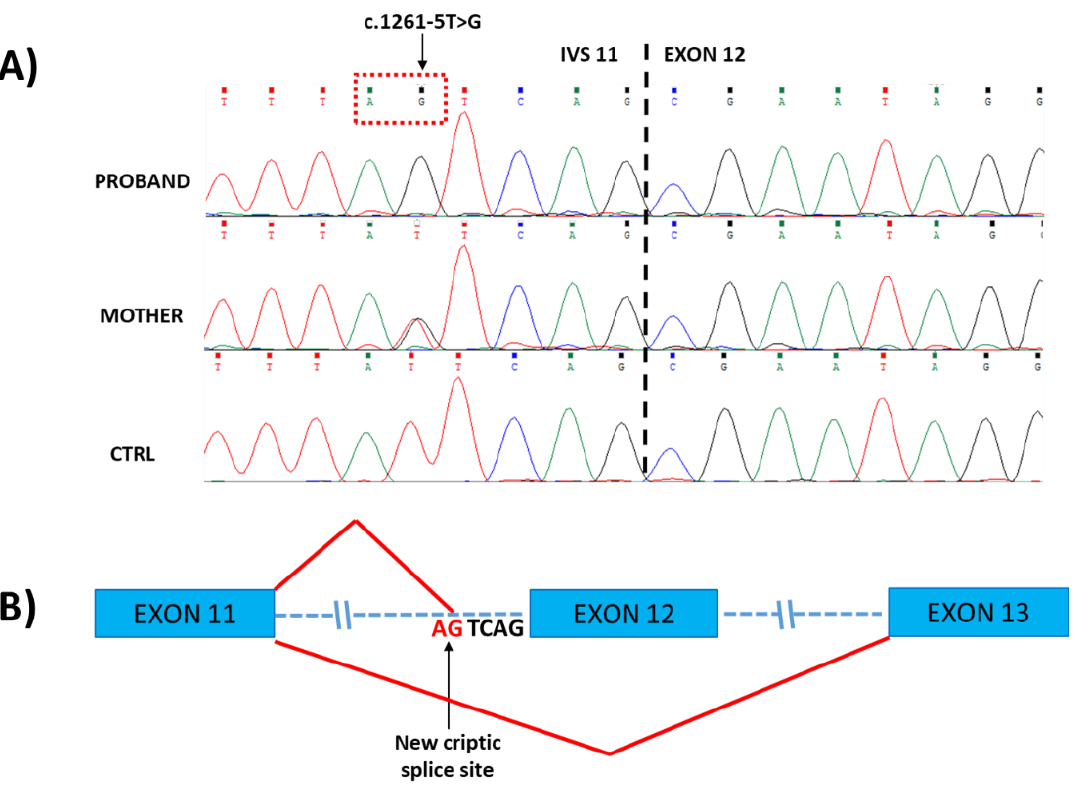
Figure 2. ( A ) Sanger sequencing of genomic DNA from Proband and his mother, showing the local- ization of the c.1261-5T>G variant in IVS11 inherited from the heterozygous mother. ( B ) Schematic representation of patient’s abnormal splicing processes, generating two different transcripts simul- taneously expressed in muscular cells: the first aberrant transcript is generated by the activation of a cryptic splice site in intron 11 (indicated by the arrow), leading to the insertion of 4 bp (UCAG) upstream of exon 12; in the second aberrant transcript, exon 12 is skipped.